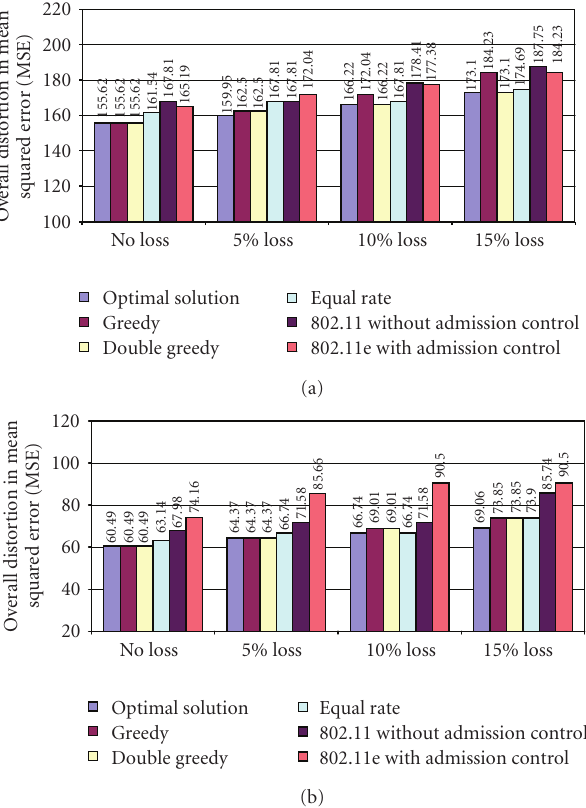
Figure 9: Distortions resulted from using various protocols: (a) using video profiles I with channel capacity set to 1Mbps, (b) using video profiles II with channel capacity set to